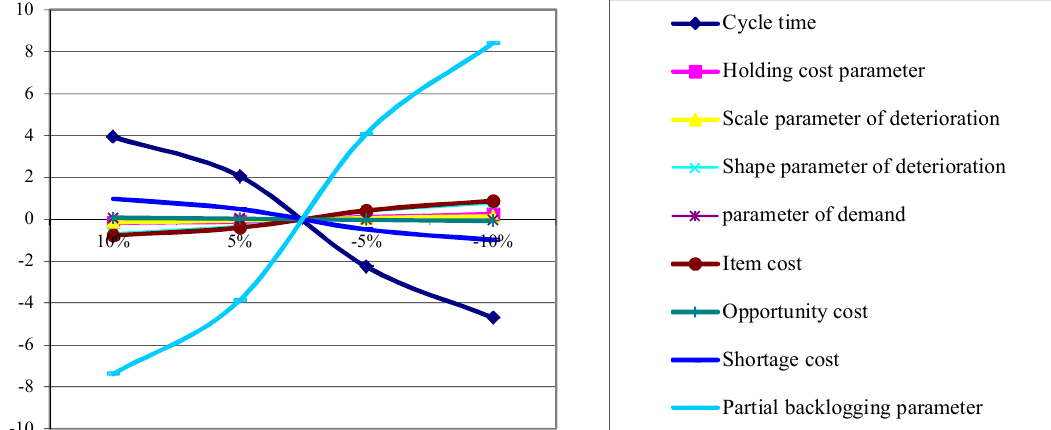
Fig. 4. Behavior of optimal ordering quantity in scenario